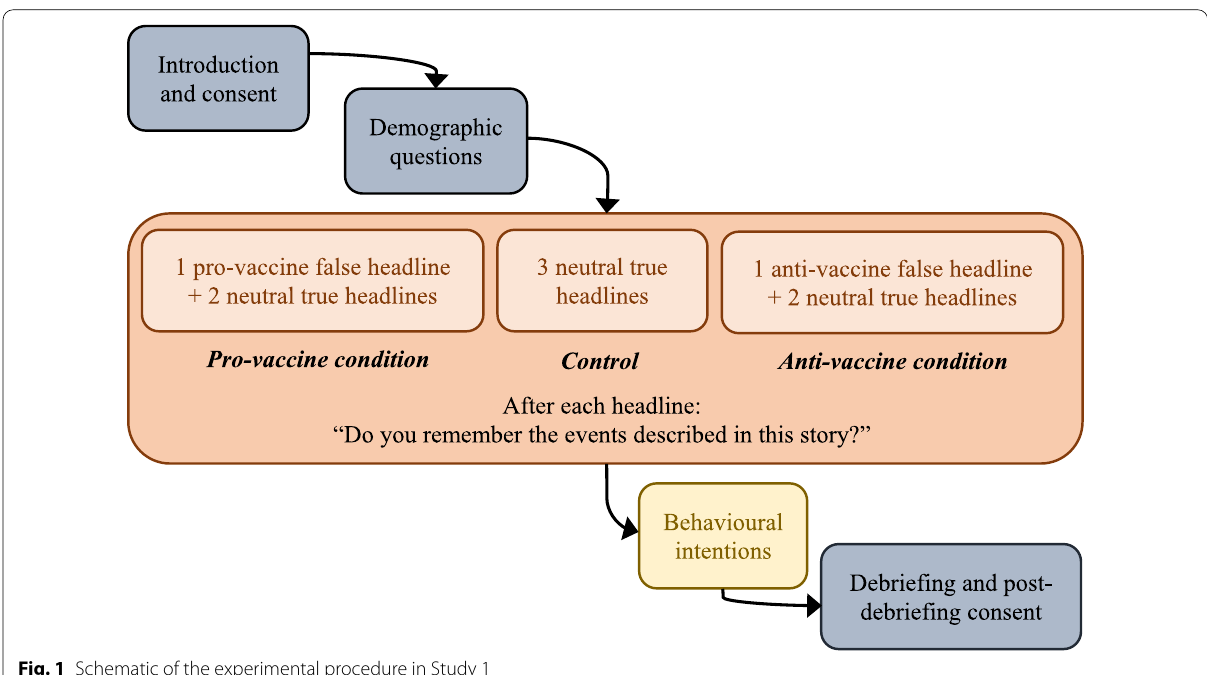
Fig. 1 Schematic of the experimental procedure in Study